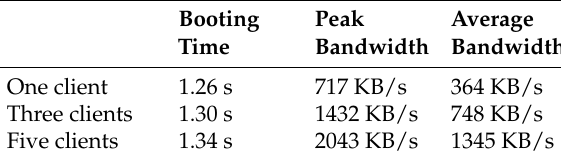
Table 3. Zephyr remote booting performance.